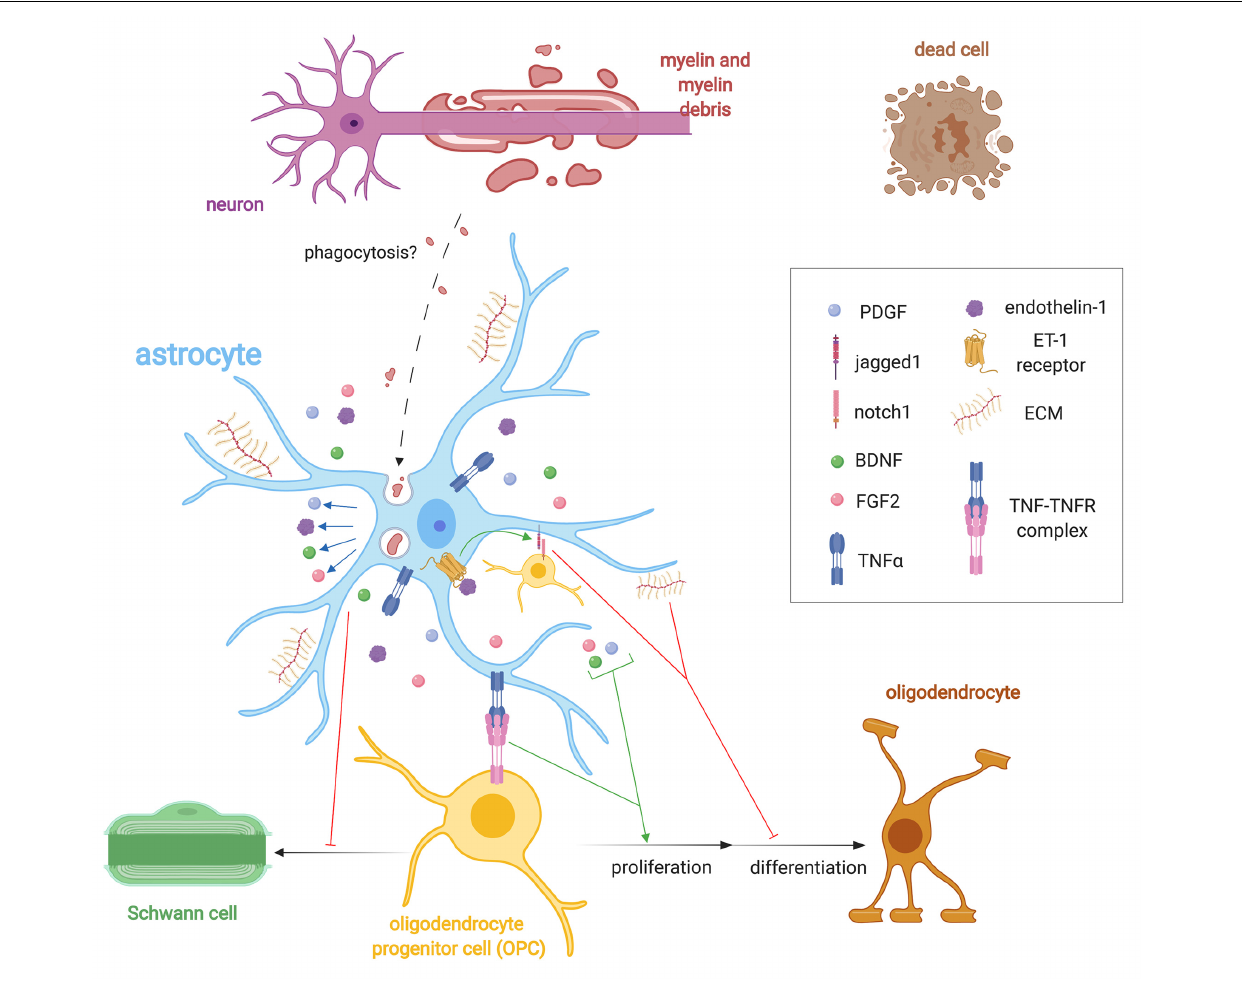
FIGURE 2 | Importance of astrocyte regulation of remyelination. Following demyelination, astrocytes help regulate OPC behavior via the expression of extracellular matrix (ECM) molecules such as CSPGs, hyluronan, fibronectin, and tenacin C, endothelin-1 and growth factor secretion such as FGF2, brain-derived neurotrophic factor (BDNF), and PDGF. Endothelin-1, through autocrine and paracrine signaling, stimulates the expression of the notch ligand jagged1 that antagonizes remyelination. Astrocytes control the fate choice of OPCs following demyelination by antagonizing their differentiation into Schwann cells (SCs). Astrocytes may phagocytose myelin debris, but this has only been validated in vitro . They also express TNF- α , which binds to TNFR2 to promote